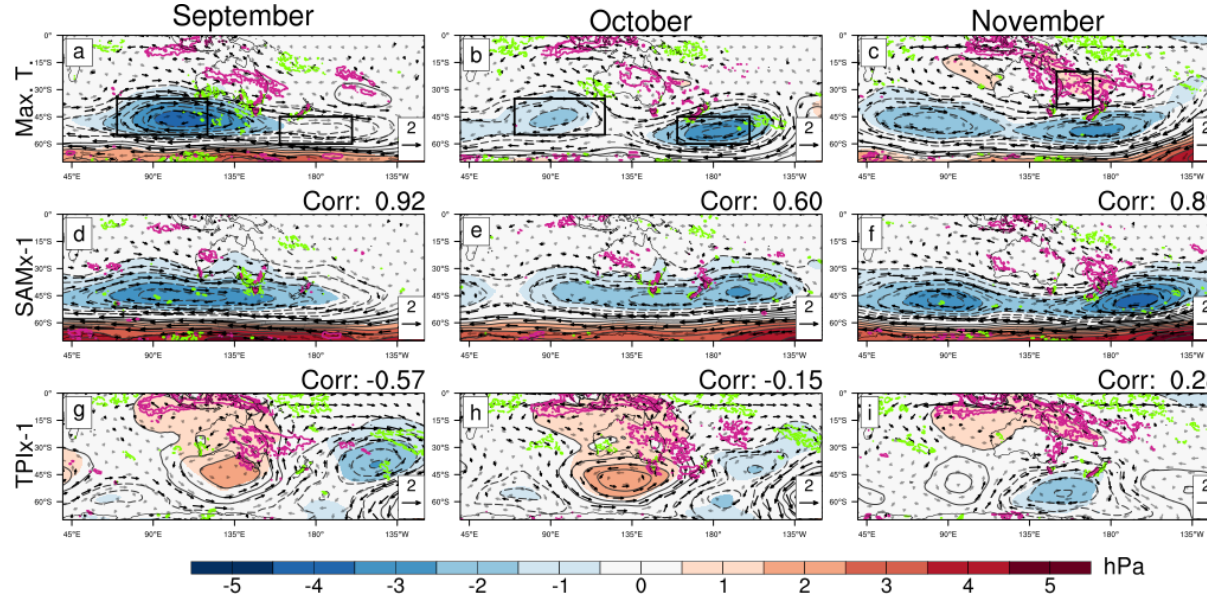
Figure 2. Regressions onto low-level circulation, as in Fig. 1, except for September (left column), October (middle column), and November (right column). Standardised area-averaged Australian maximum temperature is linearly regressed onto low-level circulation (a–c) , and SAMx-1 (d–f) and tropical TPIx-1 (g–i) are multilinear regressions onto low-level